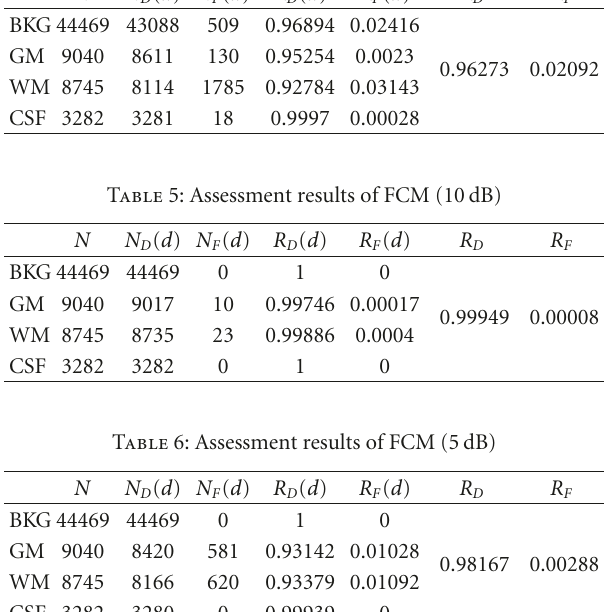
Figure 11: Classification results of CSA in actual brain MRIs: (a) GM; (b) WM; and (c) CSF. Table 4: Assessment results of perceptron network (5dB) N